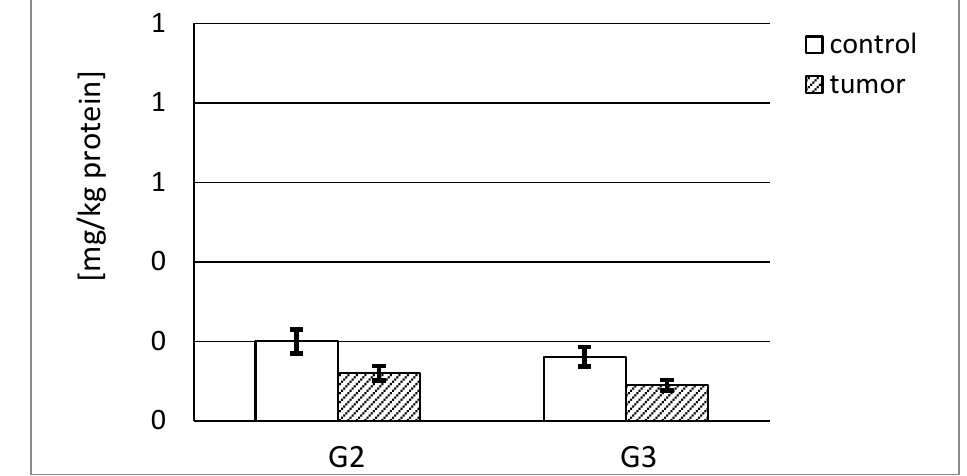
Figure 2. Content of MMP-3 in respective control tissue and G2 grade and G3 grade human kidney tumor. p < 0.001—cancer vs. respective control kidney; p < 0.001—G3 grade vs. G2 grade human kidney cancer.